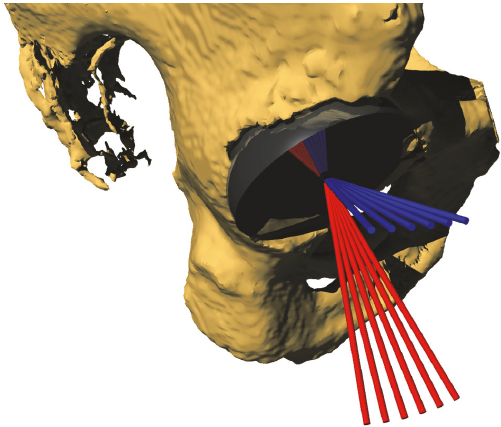
Figure 3: Solid modeling of pelvis, cup and vectors generated by changing pelvic tilt (rotation in sagittal plane). Red lines = vectors normal to the flat cup surface. Blue lines = red lines projected onto the axial plane representing functional